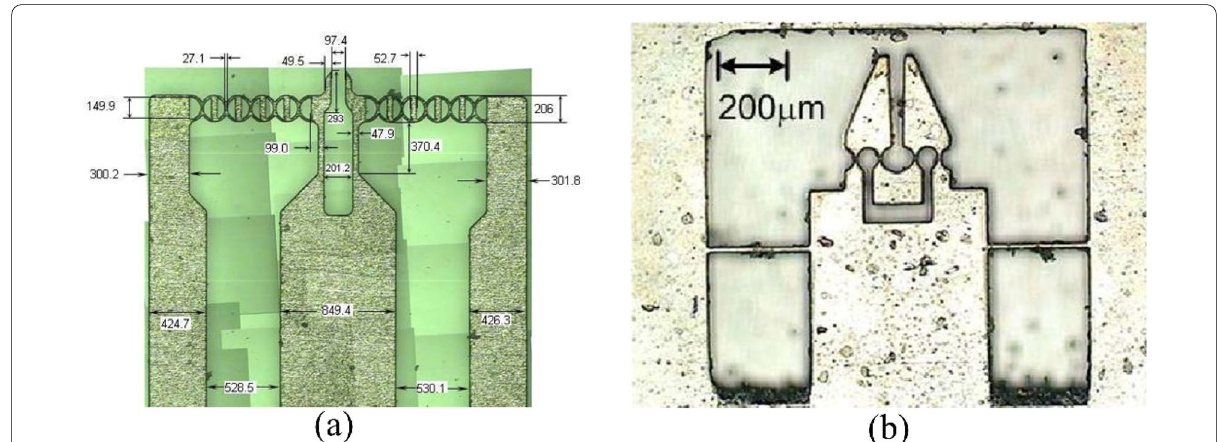
Figure 4 Microgrippers machined using laser technology: ( a ) Microgripper fabricated using nickel foil [62] (©IEEE. Adapted by permission of IEEE. Permission to reuse must be obtained from the rightsholder), ( b ) Microgripper fabricating using PU film [63] (©IEEE. Adapted by permission of IEEE. Permission to reuse must be obtained from the